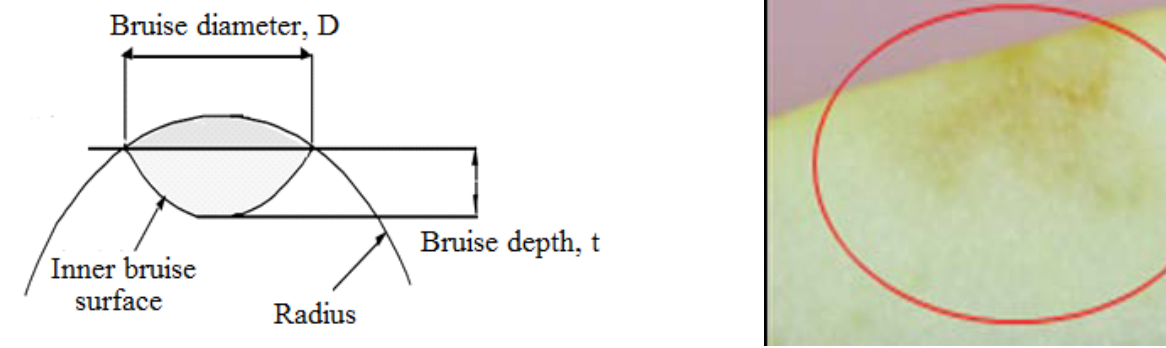
Figure 3. Bruise volume calculation and the shape damage for the flesh cantaloupe.